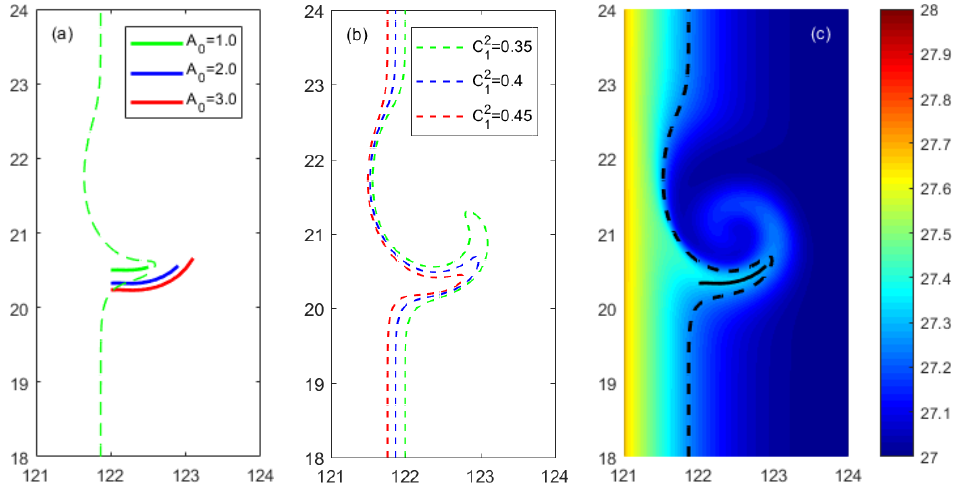
Figure 11. Filaments for ( a ) various eddy tangential velocities, ( b ) various lateral SST gradients across the Kuroshio. Dashed lines: isotherms. Solid lines: detected warm filaments. ( c ) The temperature field for the baseline case. The contour and central curve illustrate the width and length of the warm filament,